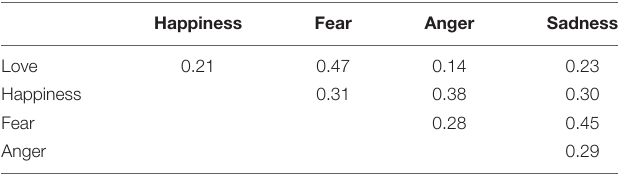
TABLE 1 | Correlation coefficients between all five subscales of the ECS, all p s < 0.002. Happiness Fear Anger Sadness